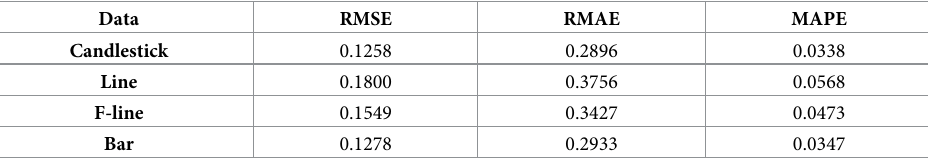
Table 2. Comparison of out-of-sample results for stock chart images using the SC-CNN